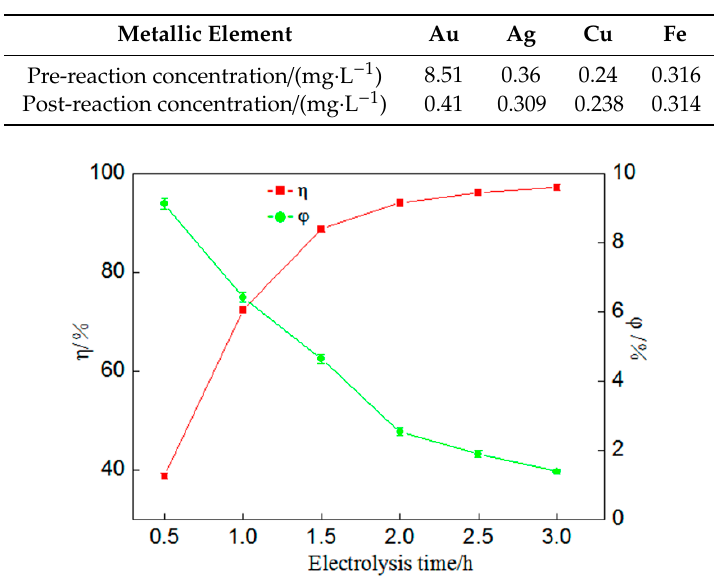
Figure 8. Effect of actual iodine leaching solution electrodeposition of gold (percentage of gold deposition η , coulombic efficiency φ ).